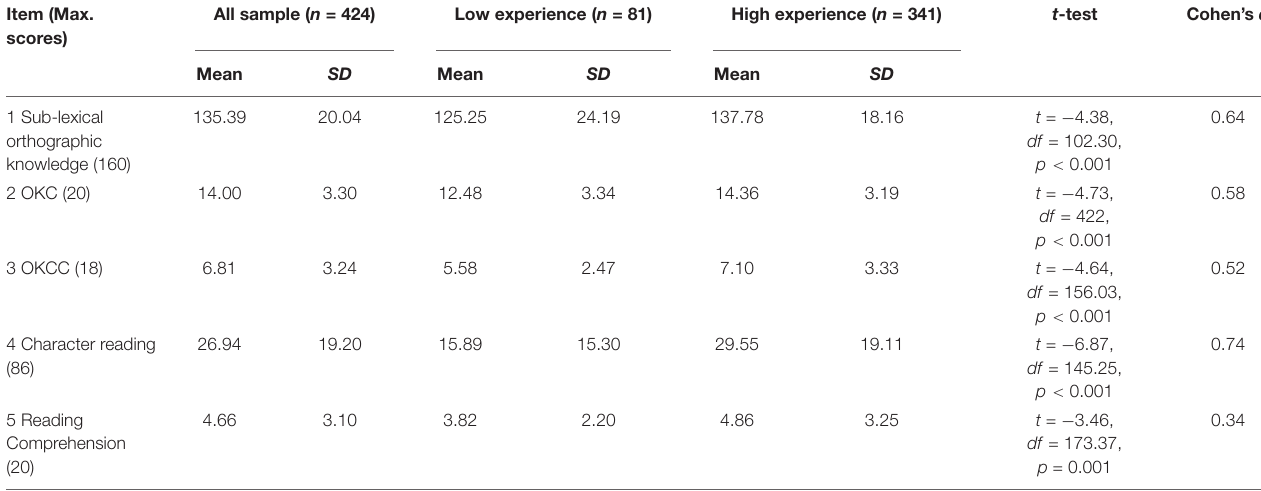
TABLE 1 | Descriptive data of students’ performance in four tasks. Item (Max. scores)